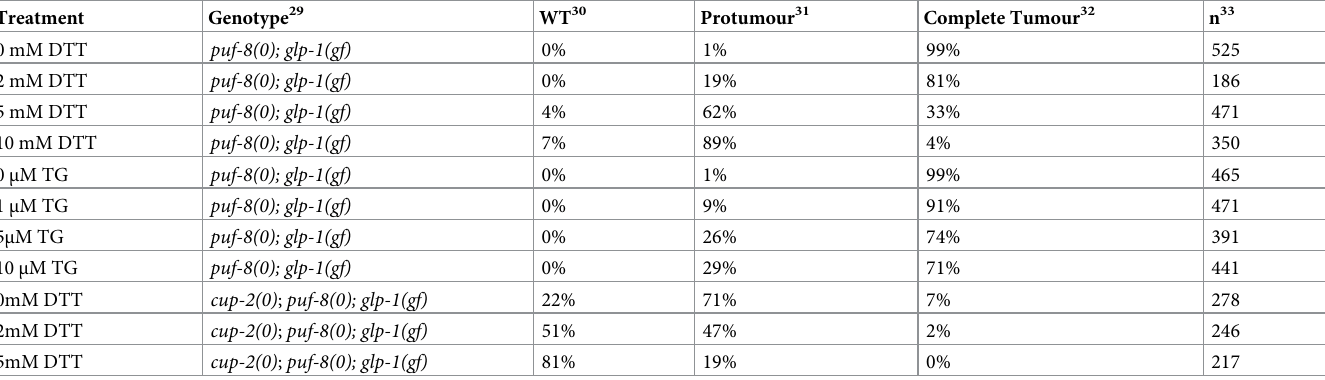
Table 6. DTT and Thapsigargin (TG) suppress glp-1(gf) overproliferation in a dose-dependent